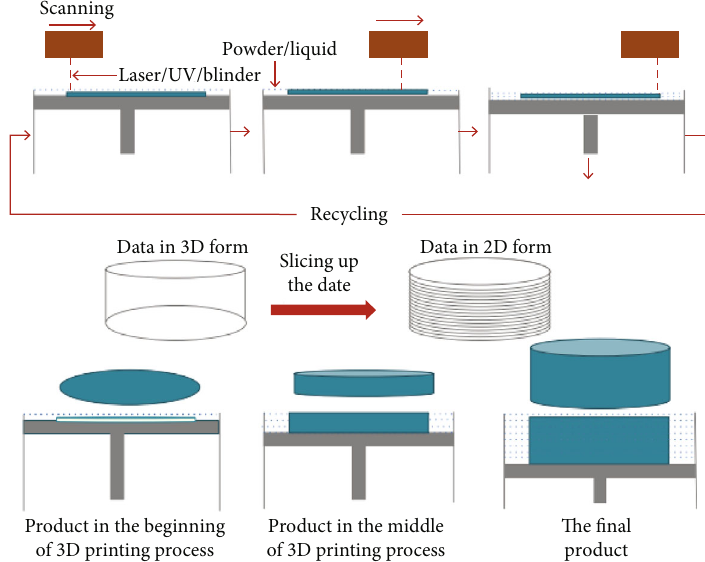
Figure 1: Schematic representation of 3D printing